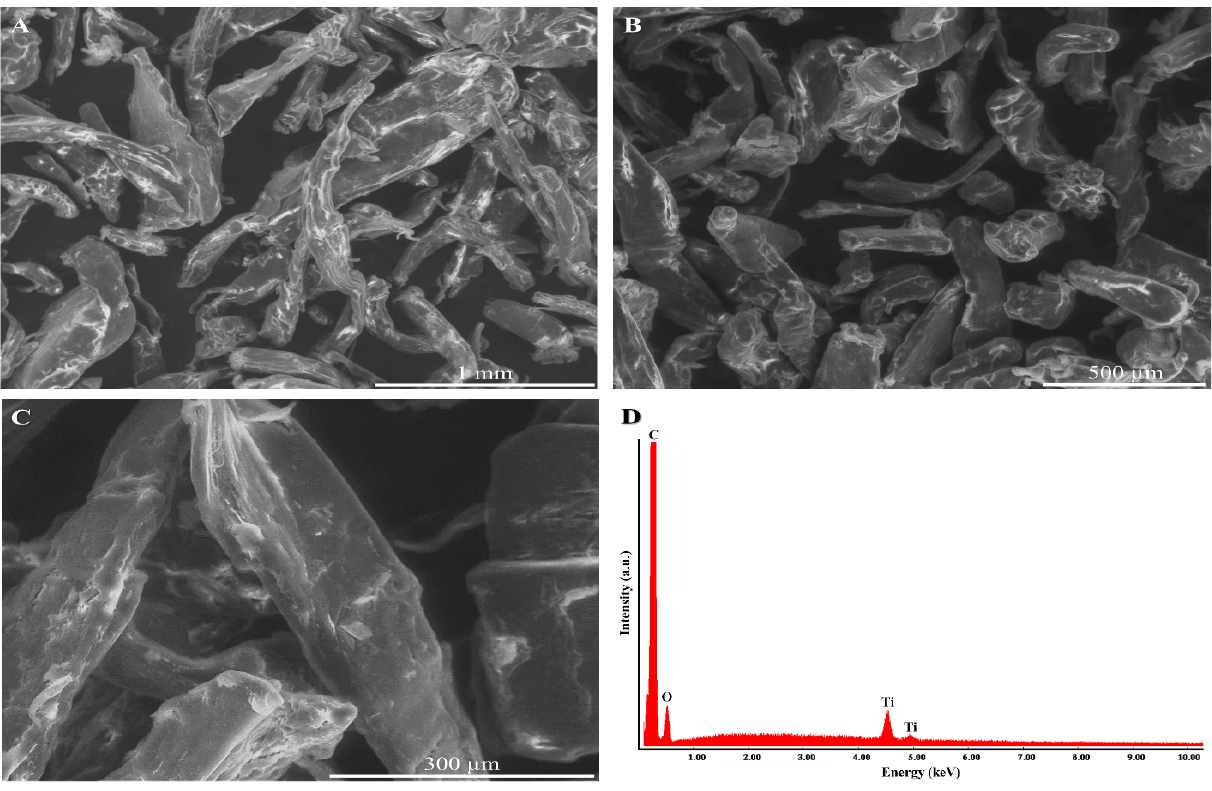
Figure 1. Scanning electron microscopy (SEM) images of microplastic particles showing the triturated surface cracks from low to high magnification (from ( A – C )). Electron dispersive X-ray spectroscopy (EDS) spectrum ( C ) showing C and O peaks as expected from the types of polystyrene and showing titanium (Ti) indicating the presence of white pigments ( D ).